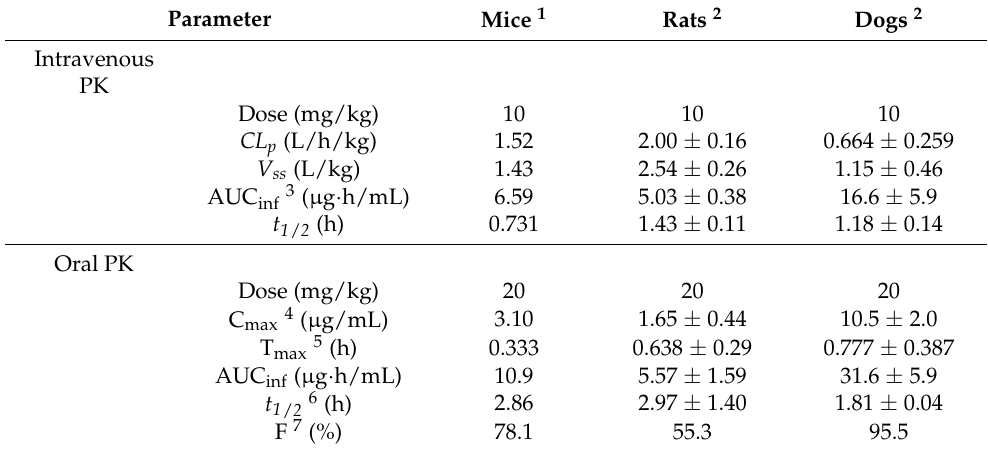
Table 1. IDP-73152 PK parameters following intravenous and oral administration to mice, rats, and dogs. Parameter Mice 1 Rats 2 Dogs 2 Intravenous PK Dose